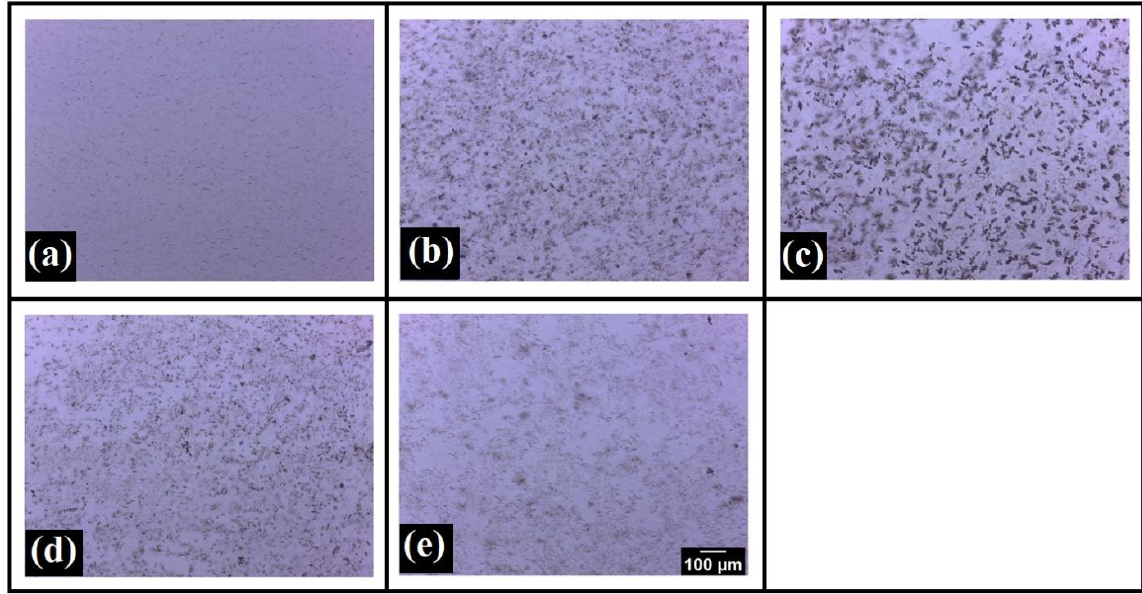
Figure 2. Bright-field micrographs: ( a ) SE0, ( b ) SE1, ( c ) SE3, ( d ) SE5, and ( e ) SE10. Further, wax microarchitecture was visualized using a polarized light microscope